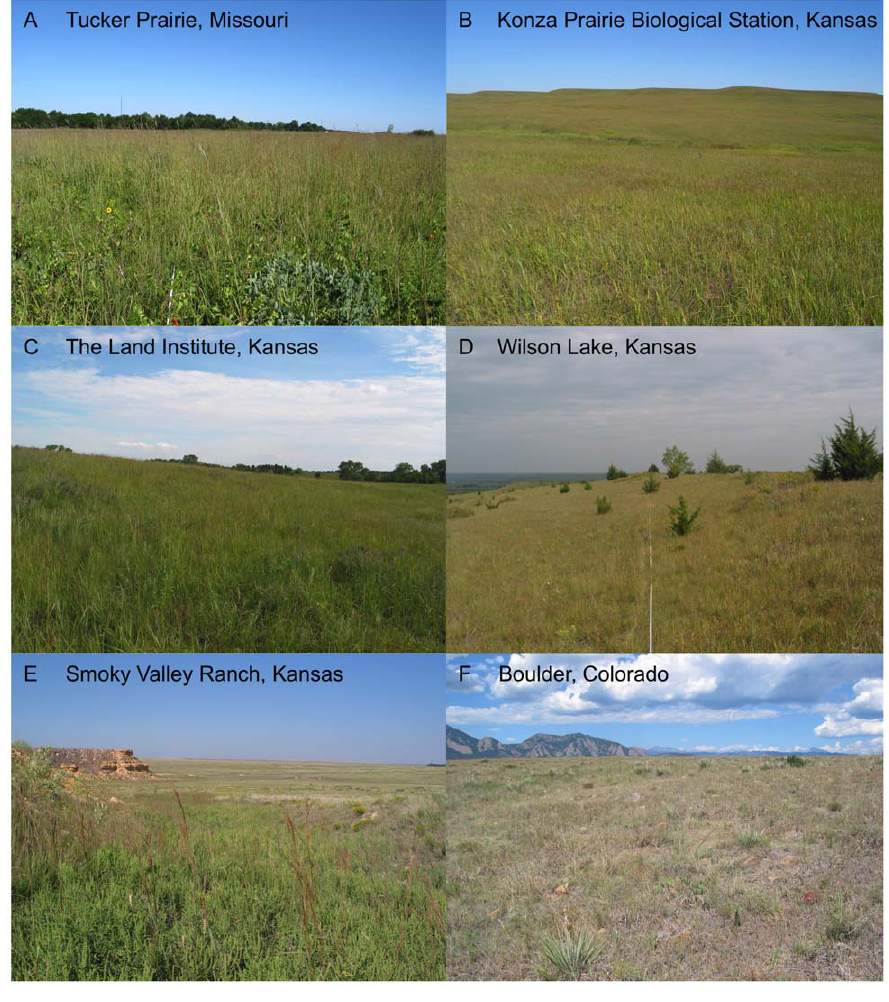
Figure 2. Collection sites for Andropogongerardii .